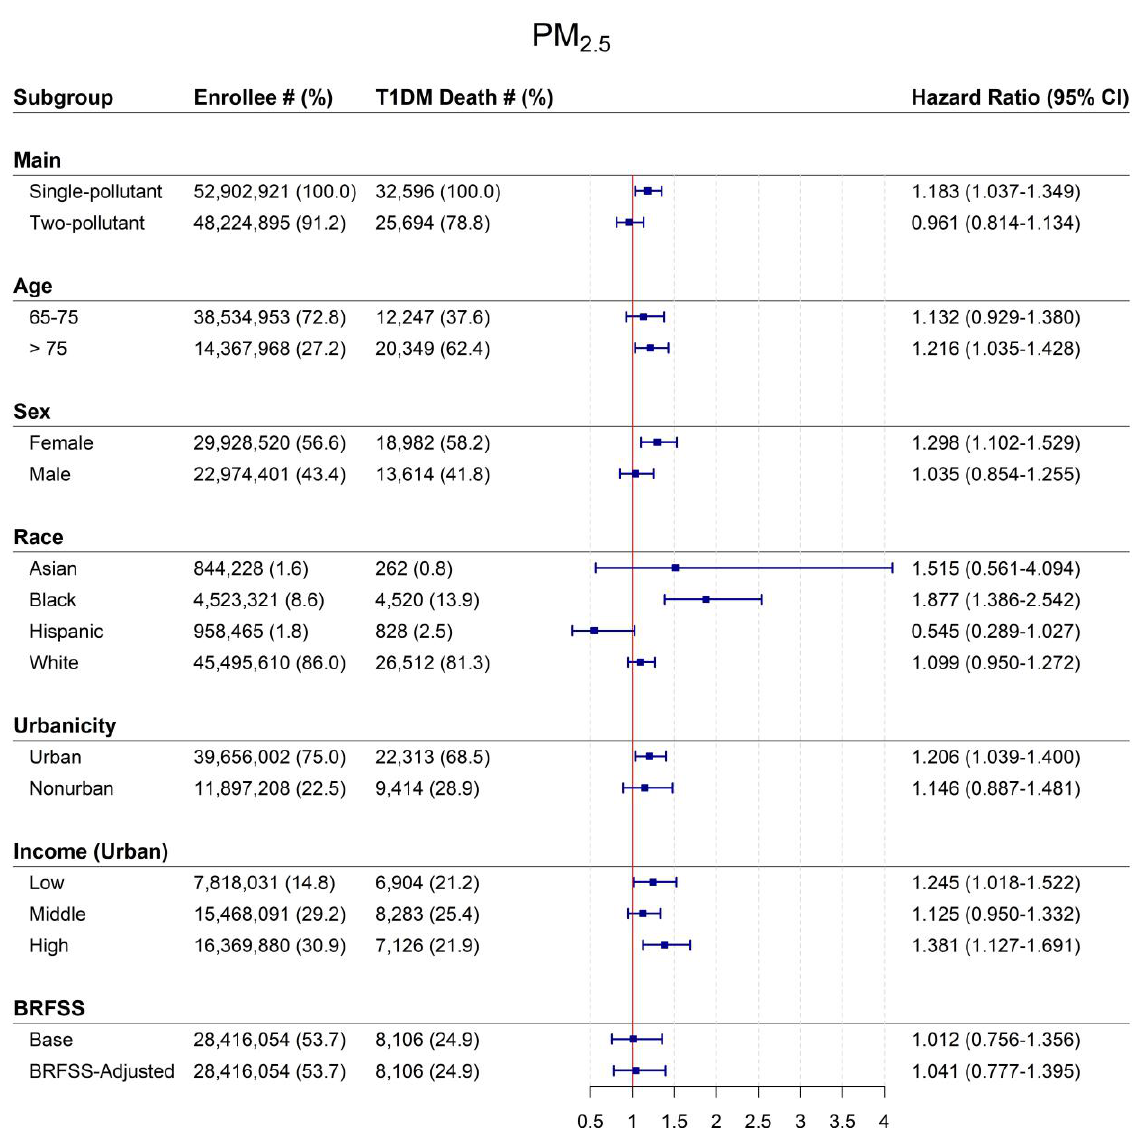
Figure 1. Mortality hazard ratios (95% CI) associated with a 10 µ g/m 3 increase in 12-month average PM 2.5 for entire population and by subgroup, US 2000–2008. Abbreviations: CI = confidence interval; PM 2.5 = particles with aerodynamic diameters < 2.5 µ m; T1DM = type 1 diabetes mellitus. BRFSS data were not available for all of the Medicare participants included in our full analyses. As such, the sample size for these sub-analyses is smaller. Table 2. Type 1 diabetes mortality hazard ratios (95% CI) associated with a 10 μg/m 3 increase in 12- to 60-month moving average PM 2.5 , US 2000 – 2008.